Question: What style of plot is this figure drawn as?
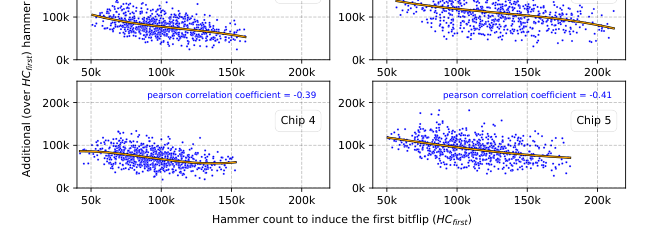
Answer: line